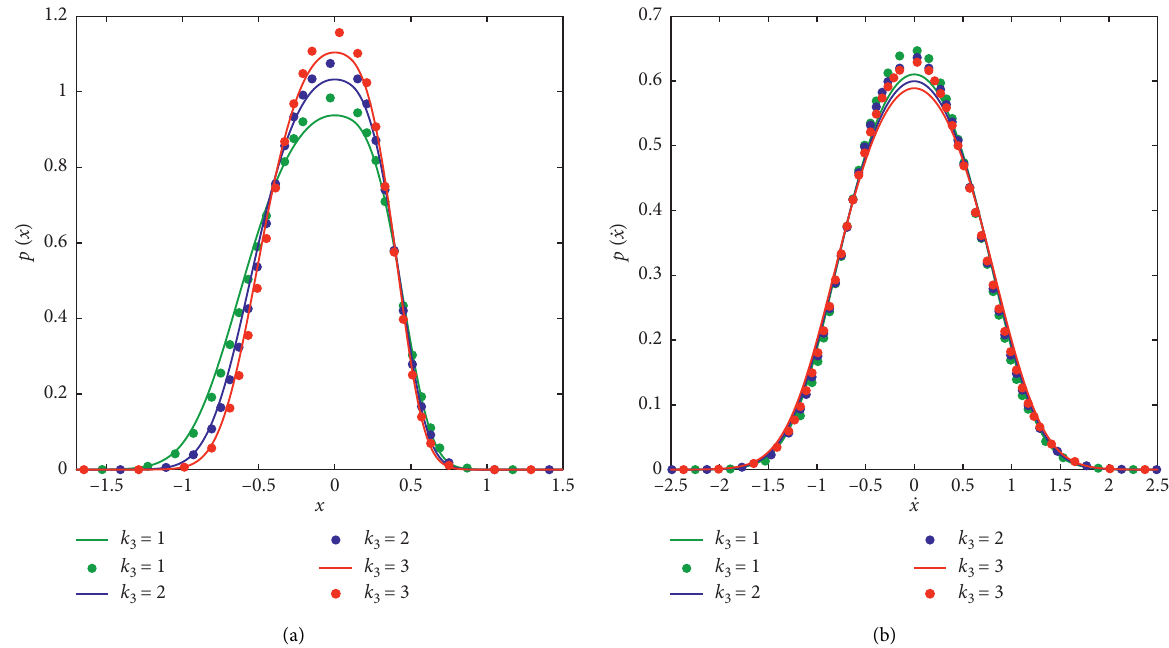
Figure 5: The PDF of the nonlinear system under different nonlinear stiffness coefficients k � 1, solid lines: the analytical results, and circles: MCS results). ( k 1